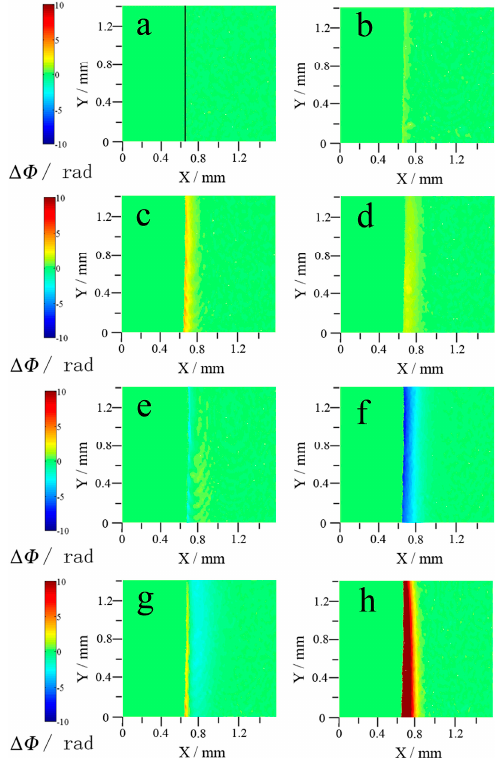
Figure 5. The phase distributions at different times in Figure 3b during potentiodynamic polarization of copper in 0.5 M NaCl + 0.01 M HCl solution. ( a–h ) are corresponding to the points a–h in Figure 3b.